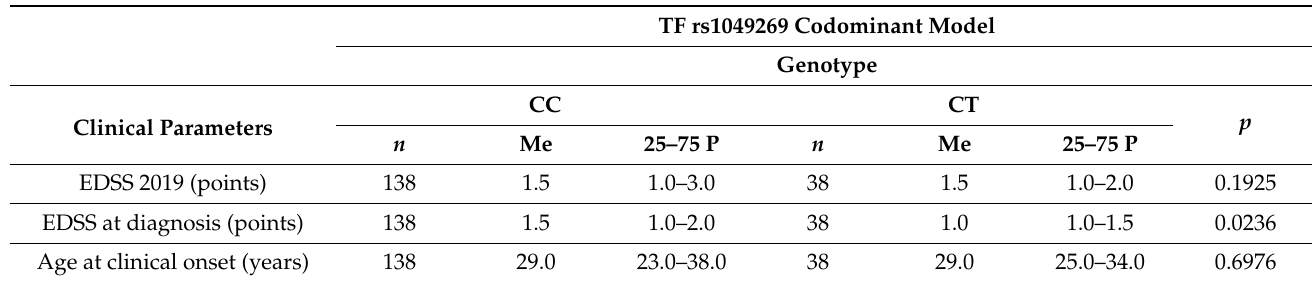
Table 7. Analysis of the relationship between the rs1049269 TF polymorphism and selected clinical